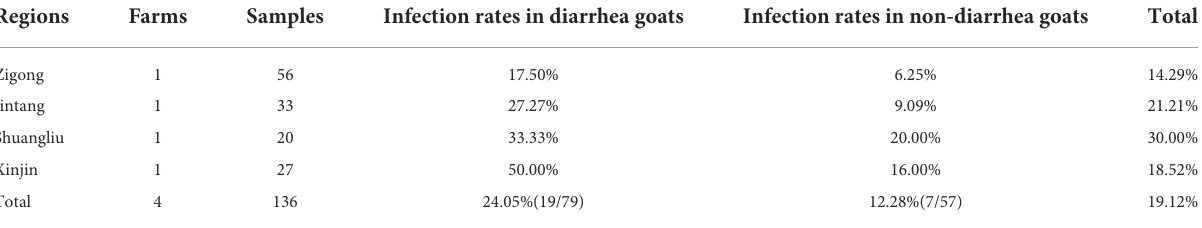
TABLE 2 Overall infection of “Bopivirus B” in Chinese goats.